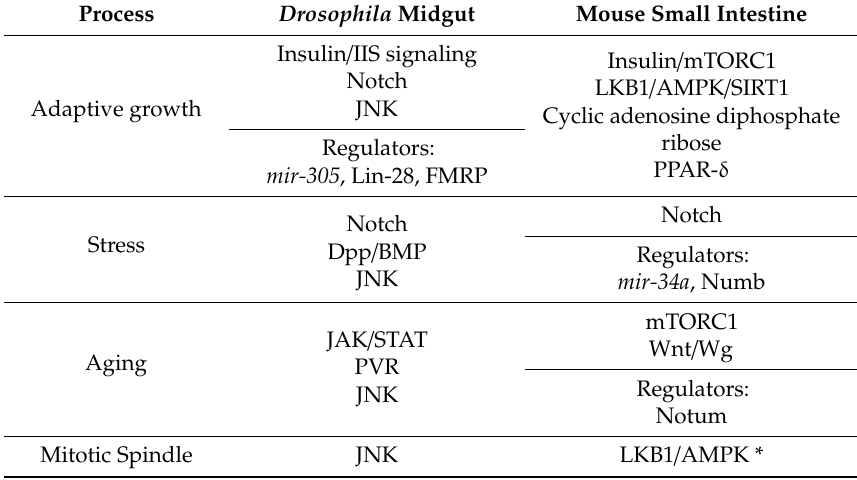
Table 1. Summary of the signaling pathways and their regulators (when known) involved in the gut responses to adaptive growth, stress, and aging both in Drosophila and the mouse. The pathways regulating the orientation of the mitotic spindle are also indicated. However, the direct molecular role of the LKB1 / AMPK pathway in mouse ISC has not been proven (*). See the main text for